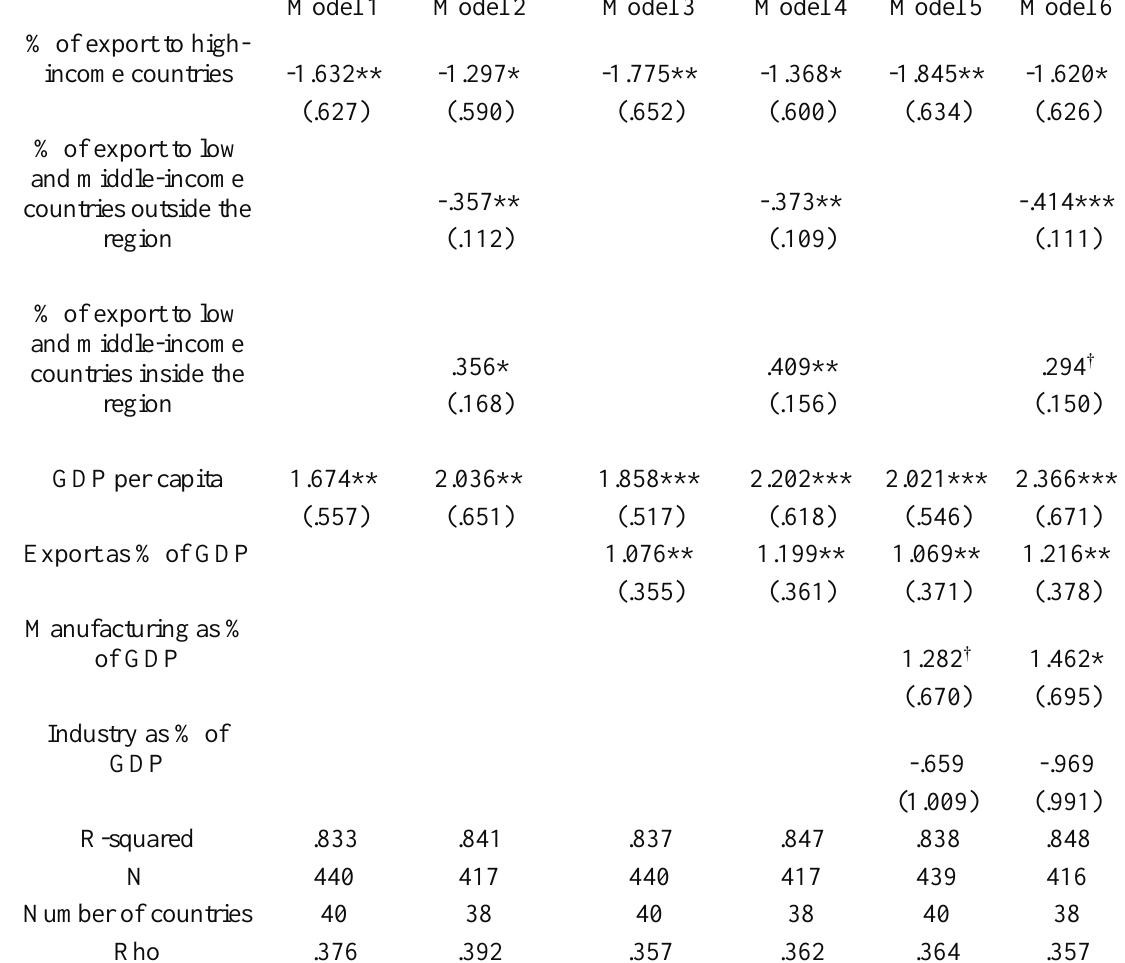
Table 4. Regression of Plastic Waste Import Trade Value, 2003-2013, Two-Way Fixed Effects PW Regression Model Estimates for 40 Non-High-Income